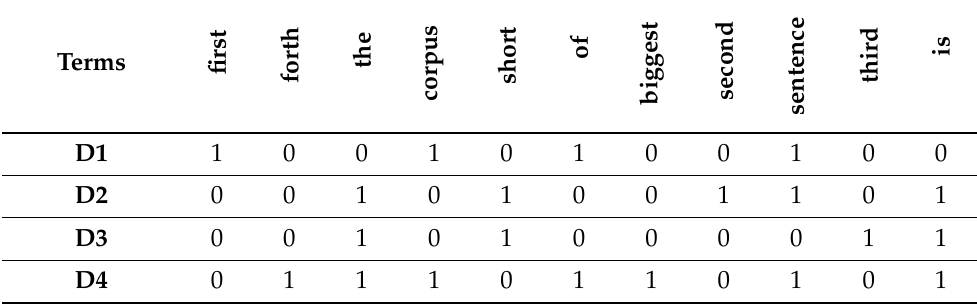
Table 5. Vector representation of the sample corpus shown in Table 4 using the binary